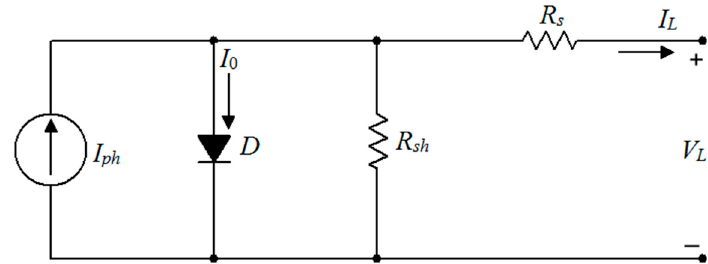
Figure 1. Single diode photovoltaic circuit model.